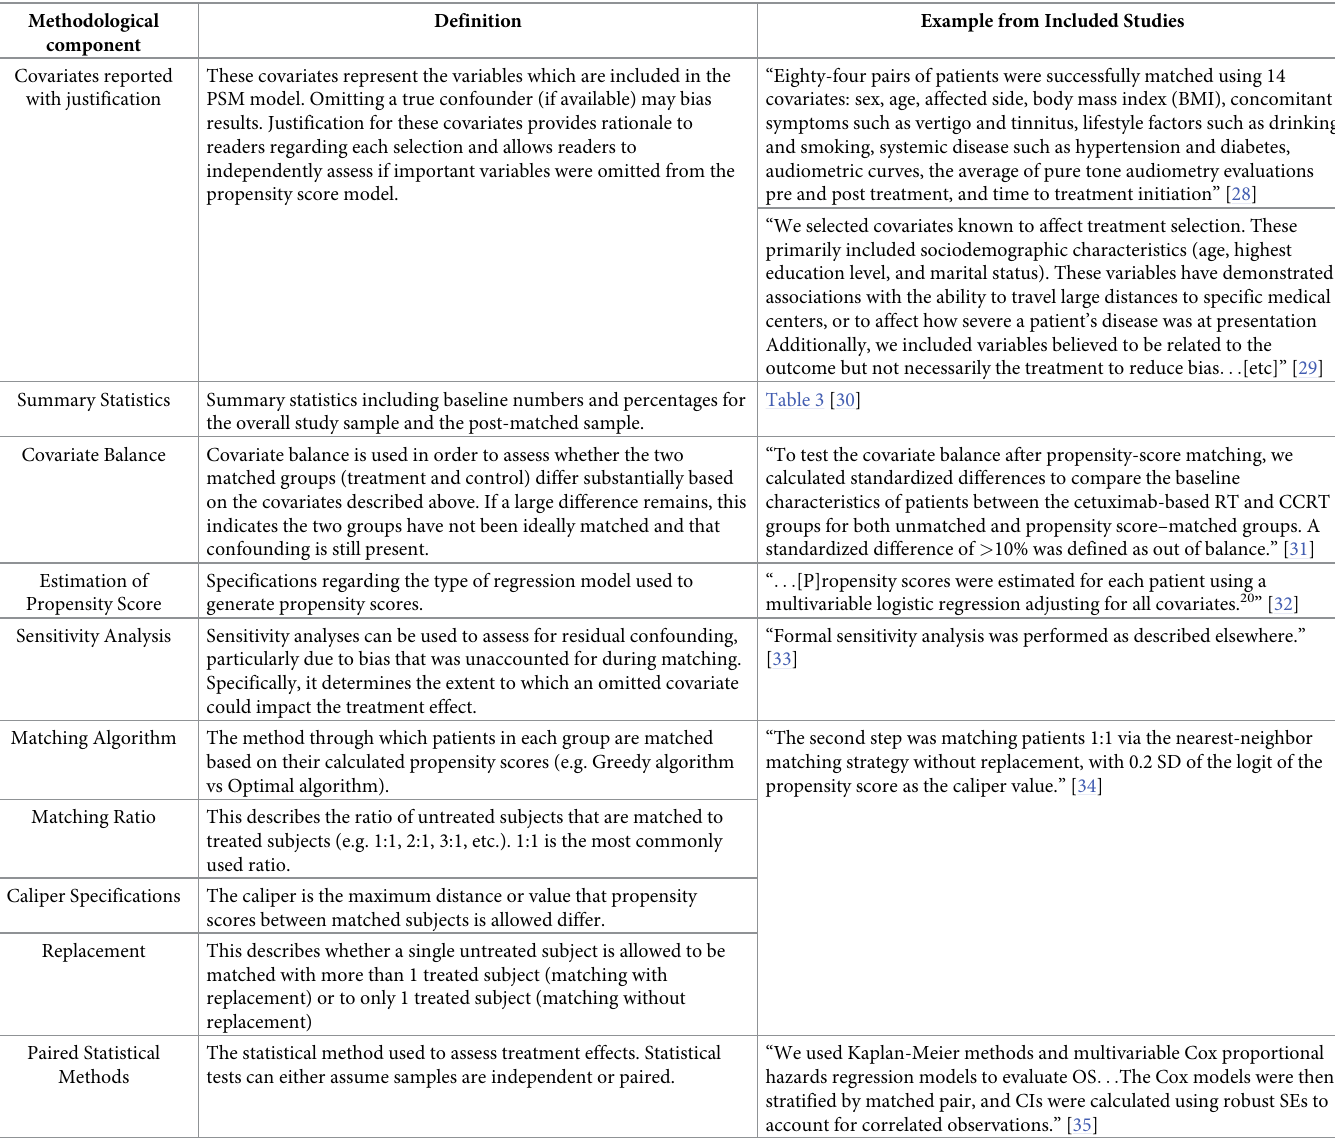
Table 1. Definitions and examples of key methodological components of propensity score